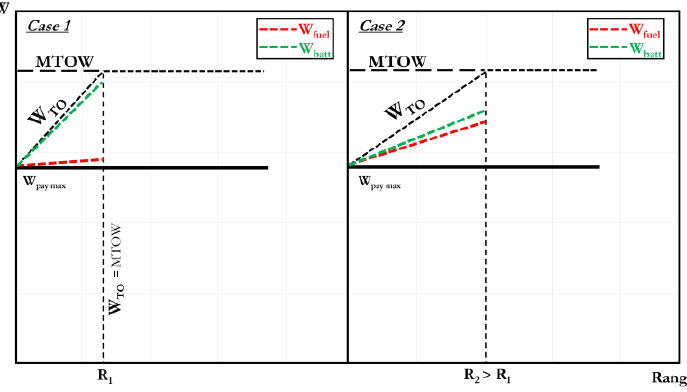
Figure 16. Effects of different fuel–battery mass distributions on the first segment of the payload– range diagram for hybrid-electric aircraft.